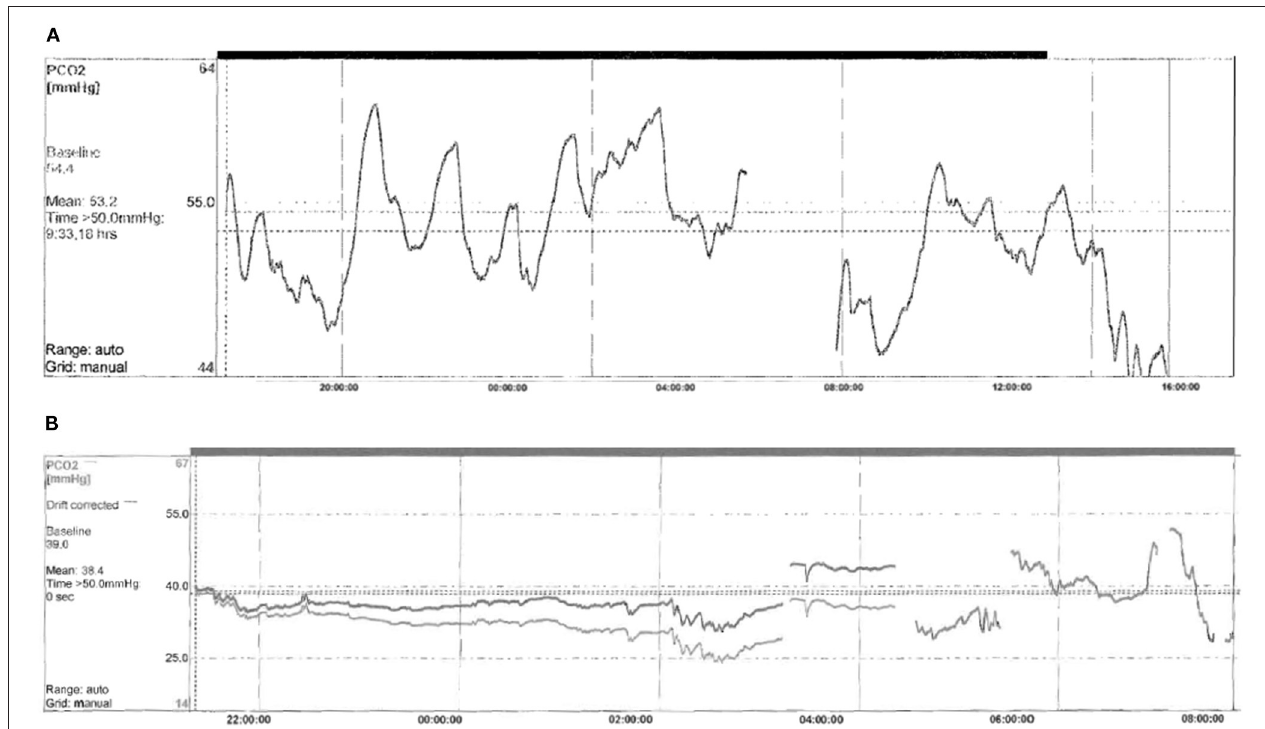
FIGURE 2 | Example of capnography at baseline (A) and after starting NIV (B) in a newly diagnosed infant with CCHS. (A) Capnography made in spontaneous breathing. Monitoring time 10.18h mean TcPCO2 53.2 mmHg, maximum TcPCO2 61.2 mmHg, minimum TcPCO2 46 mmHg, and time % spent with TcPCO2 > 50 mmHg 84%. (B) Capnography made on NIV. Monitoring time 10.24h mean TcPCO2 38.4 mmHg, maximum TcPCO2 47.3 mmHg, minimum TcPCO2 34.2 mmHg, and time % spent with TcPCO2 > 50 mmHg